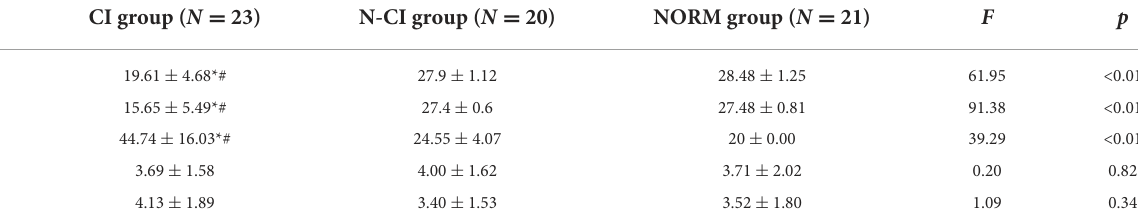
TABLE 2 Neuropsychological tests of the study